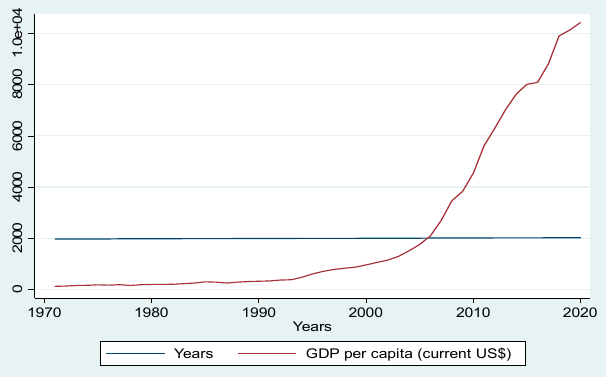
Figure 2. The electric power consumption trend for the economy of China for the period 1971–2020.